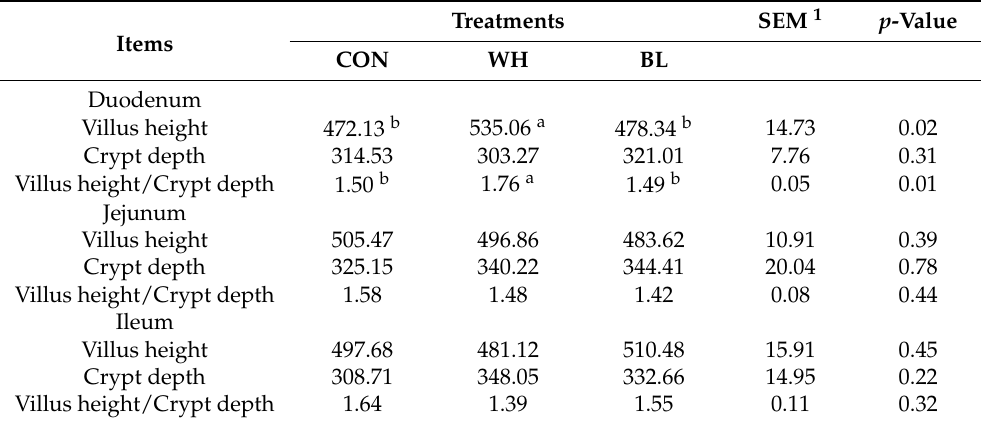
Table 5. Effects of the partial substitution of corn by wheat or barley on the villus height and crypt depth of growing pigs ( µ